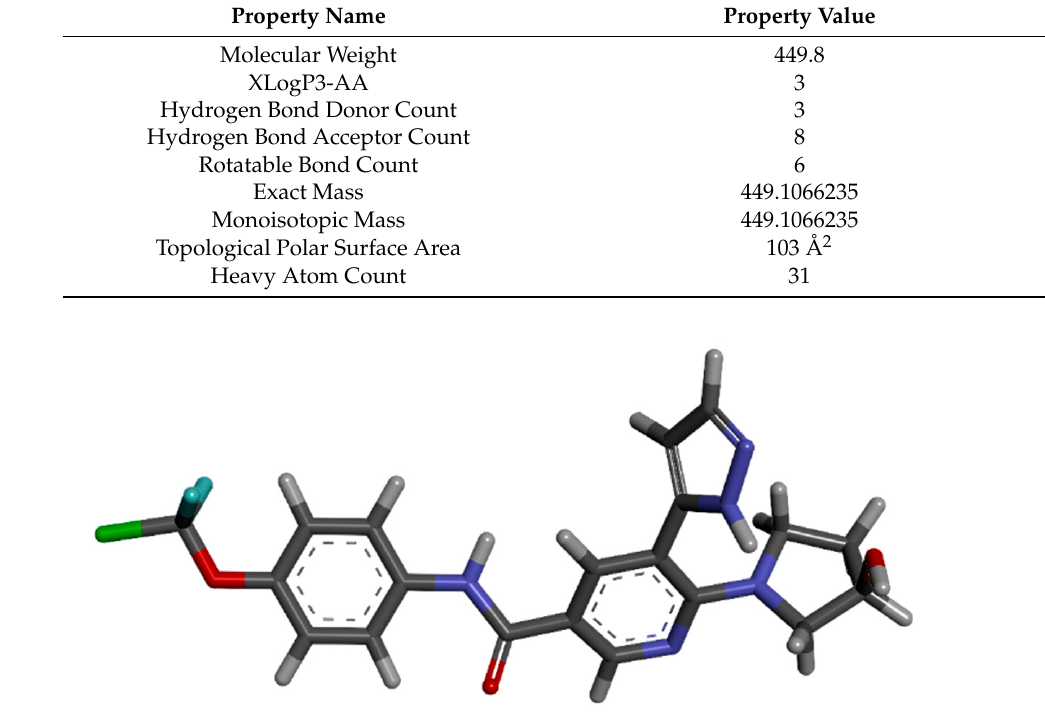
Figure 4. The 3D structure of asciminib from Puchem.